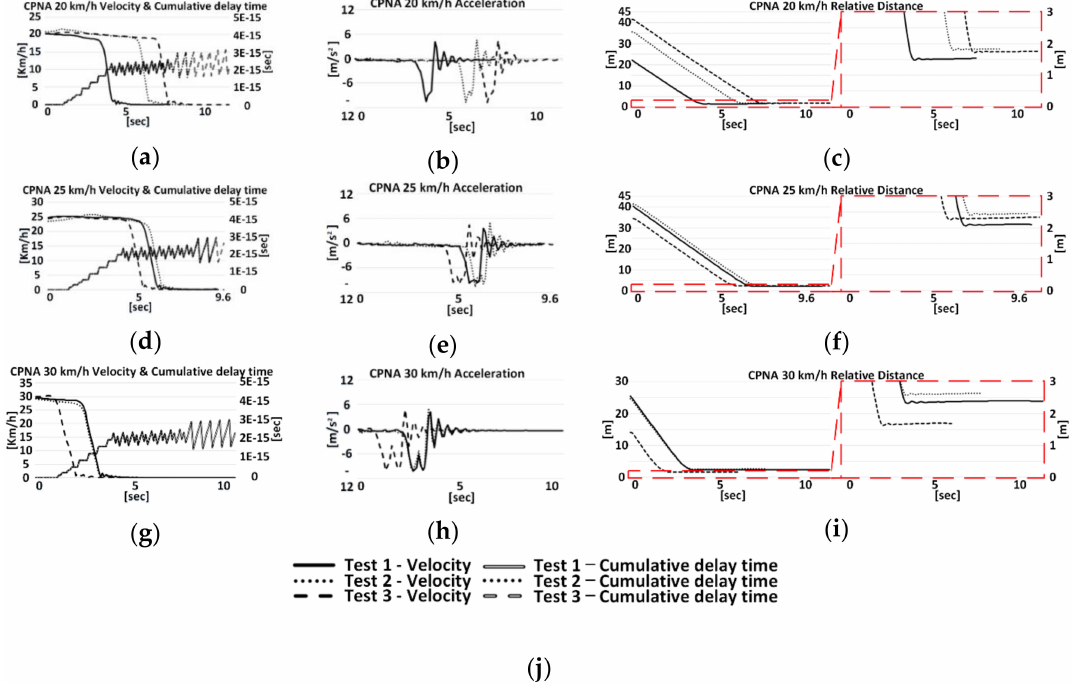
Figure 11. Test results(CPNA) ( a ) 20 km / h test velocity & cumulative delay time ( b ) 20 km / h test acceleration ( c ) 20 km / h test relative distance ( d ) 25 km / h velocity & cumulative delay time ( e ) 25 km / h test acceleration ( f ) 25 km / h test relative distance ( g ) 30 km / h velocity & cumulative delay time ( h ) 30 km / h test acceleration ( i ) 30 km / h test relative distance ( j )